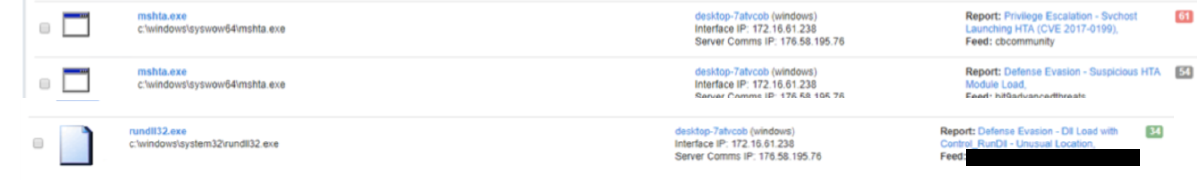
Figure 4. All alerts produced in Carbon Black.